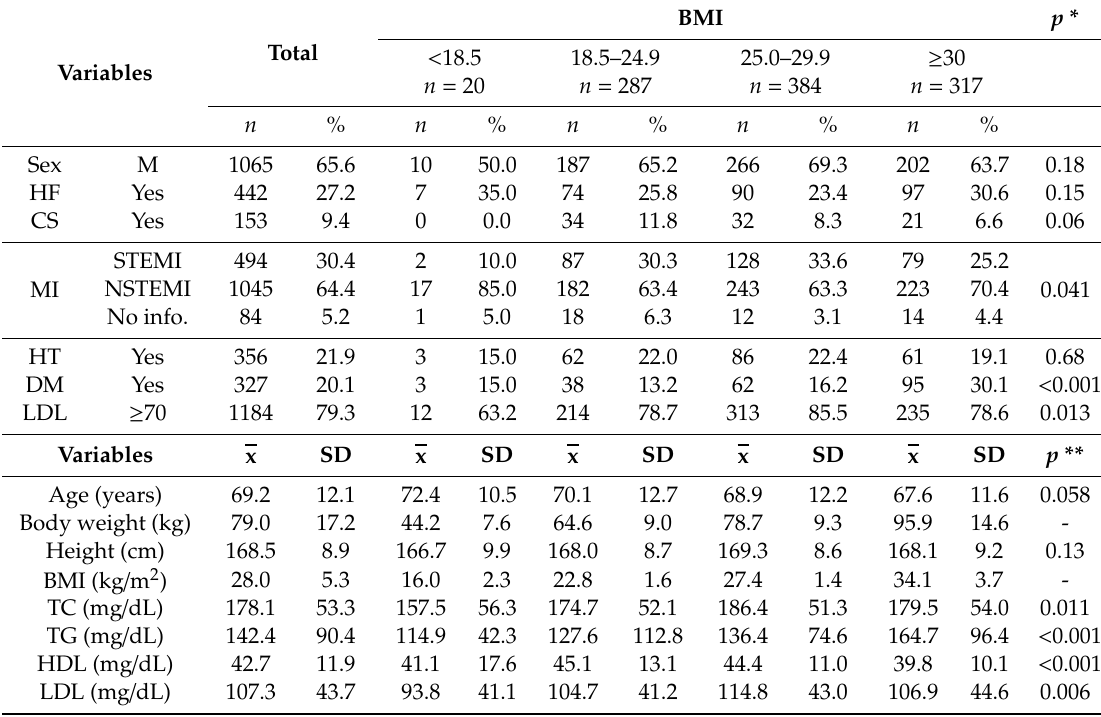
Table 2. The comparison of evaluated parameters with the ranges of BMI values.